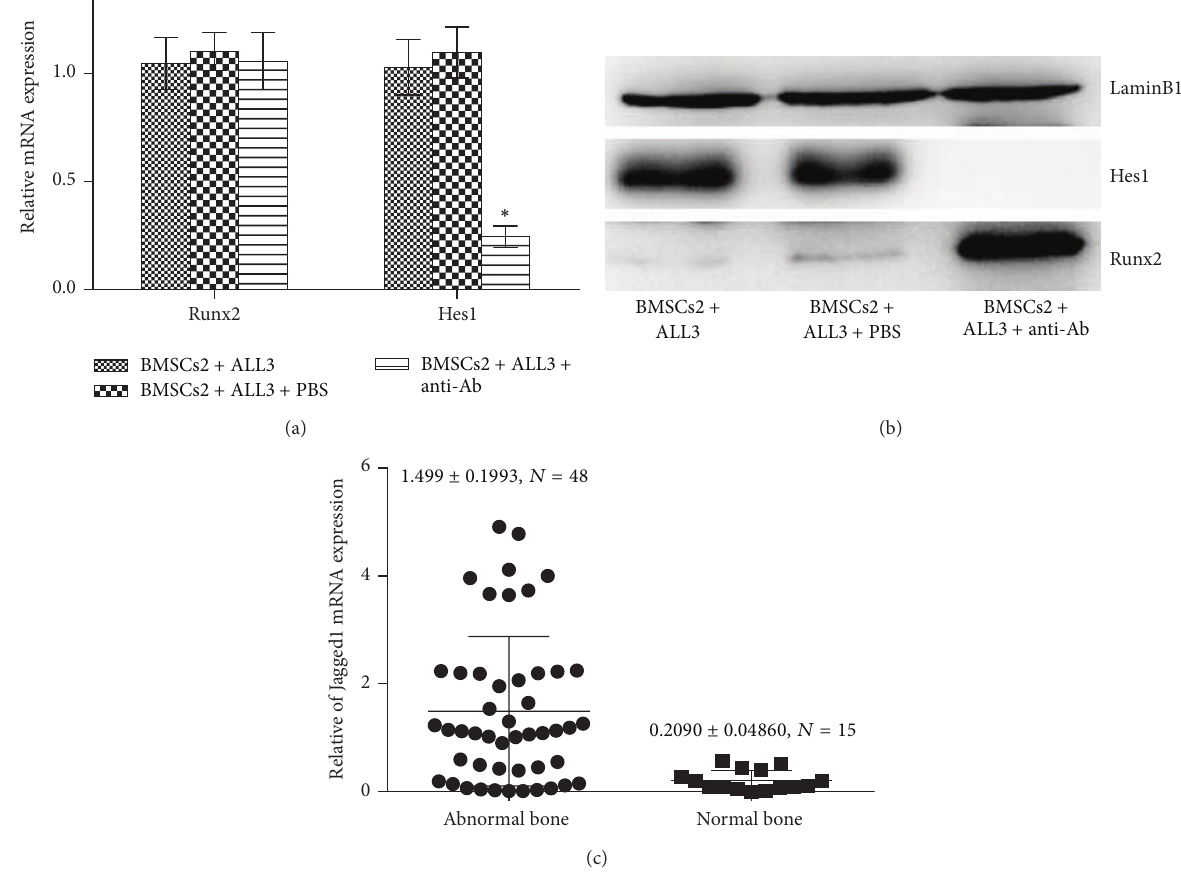
Figure 6: (a) The mRNA expression of Runx2 and Hes1 was evaluated by real-time RT-PCR in BMSCs2 after 3-day coculture with ALL cells with or without anti-Jagged1 neutralizing Ab ( ∗ 𝑃 < 0.05 versus BMSCs2 cocultured with ALL cells). (b) The protein expression of Hes1 and Runx2 were assessed. (c) The Jagged1 expression levels were evaluated in ALL cells from 63 leukemia children with or without invasion osteoclasia or osteoporosis by real-time RT-PCR. Abnormal bone represented leukemia children with invasion osteoclasia or osteoporosis.